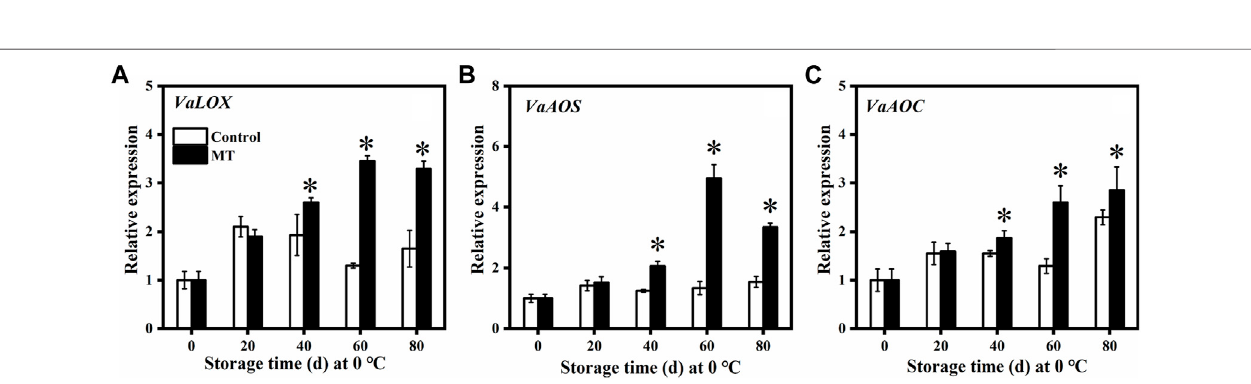
FIGURE 2 | Effects of MT treatment on the gene expressions of VaLOX (A) , VaAOS (B) , and VaAOC (C) of blueberry fruits during the postharvest storage at 0 ° C. Here, symbol * indicates signi fi cant differences ( p < 0.05). Data are presented as the mean ± SD.